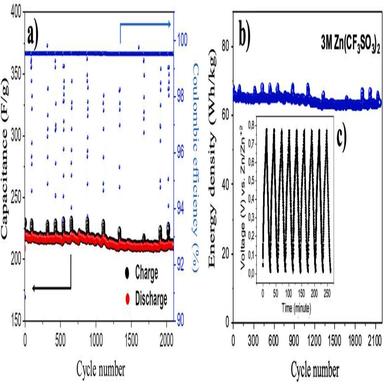
(A) Capacity-cycle number graph at 1 mA/cm2 , (B) cycle number-energy density graphs of the activated carbon//Zn hybrid supercapacitor in 3 M Zn (CF3SO3)2 aqueous electrolyte, and (C) charge-discharge curves of the full-cell (Zn//Activated carbon) at 1 mA/cm2 .